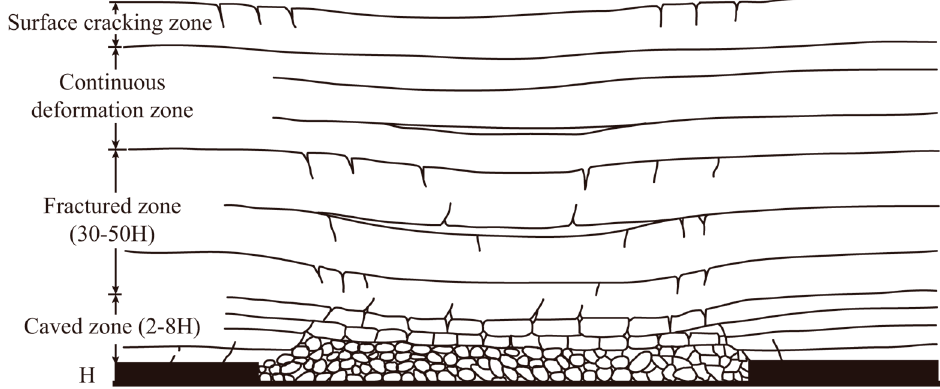
Figure 1. The four zones of disturbance in the overlying strata resulting from longwall mining.